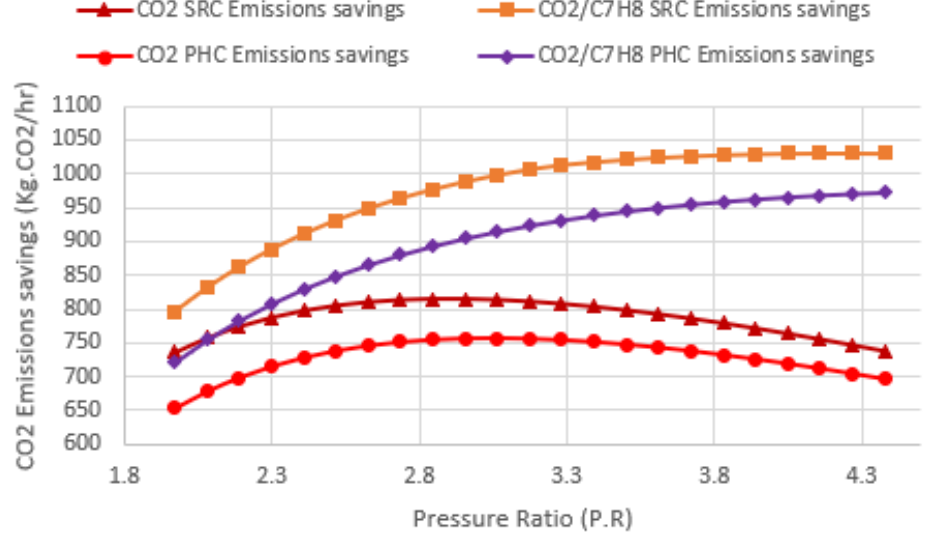
Figure 10. CO 2 emissions savings for power cycles operating with CO 2 and 0.9CO 2 / 0.1C 7 H 8 binary mixture with respect to pressure ratio.